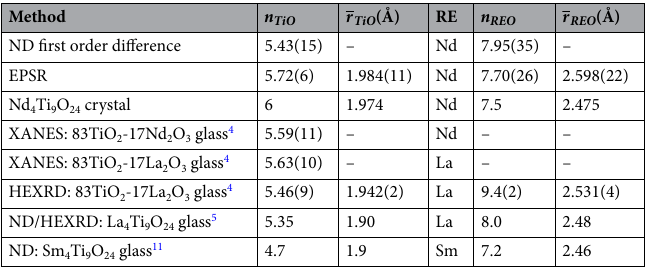
Table 1. Comparison of Ti-O and Nd-O coordination numbers from ND, EPSR, the nearest crystalline phase, and studies on compositionally similar rare-earth (RE) titanate glasses.